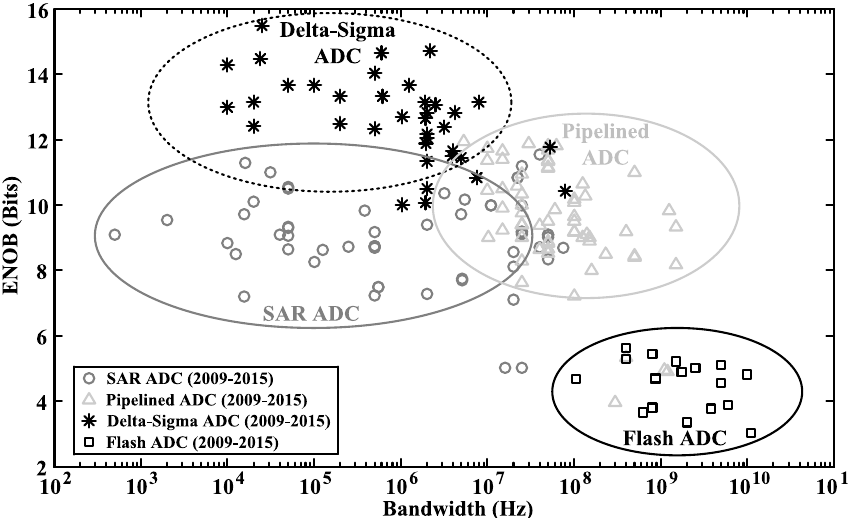
Figure 4. Performance comparison of ADC works published in the literature [33].